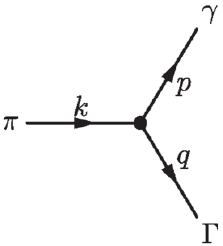
Figure 1 . Kinematics of the (cid:25) ! (cid:13) (cid:0) process, indicating our notation for the momenta of the three states; the arrows indicate the (cid:13)ow of momentum. We only consider the decay of pion at rest here, in which case k (cid:22) = ( m e(cid:11) ; 0